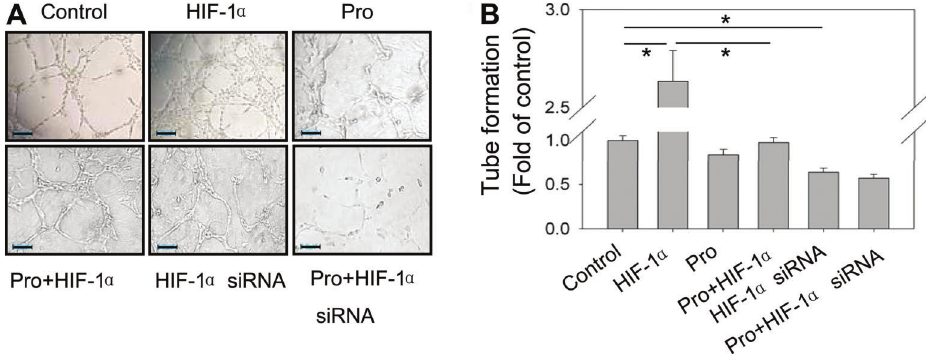
Figure 6. Overexpressed hypoxia inducible factor-1 a (HIF-1 a ) hemangioma cells and knockdown hemangioma cells treated or not with 50 m M propranolol (Pro) for 48 h. A , Representative images of tube formation (200 (cid:1) magni fi cation). B , Relative quanti fi ed values of numbers of tubes in each group. Data are reported as means ± SD of 3 random fi elds. All treatments were performed in triplicate. *P o 0.05